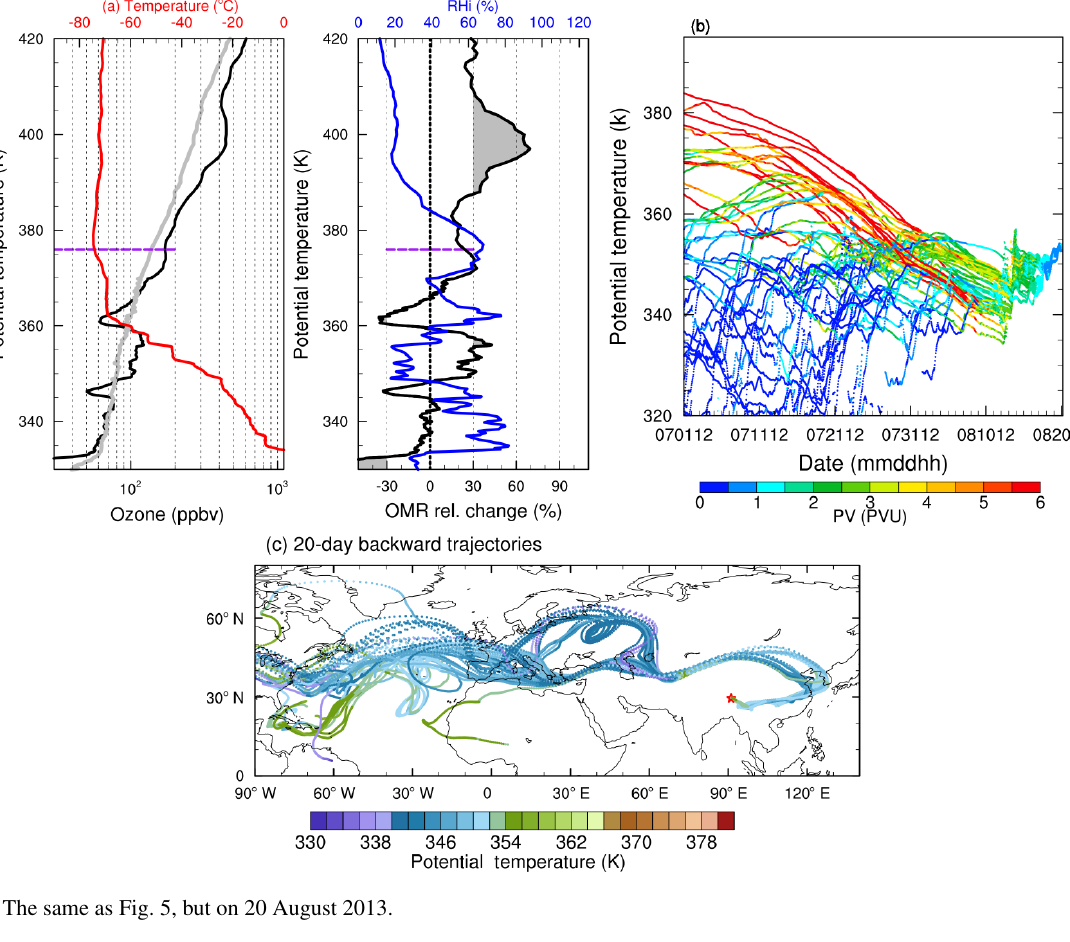
Figure 7. The same as Fig. 5, but on 20 August 2013.